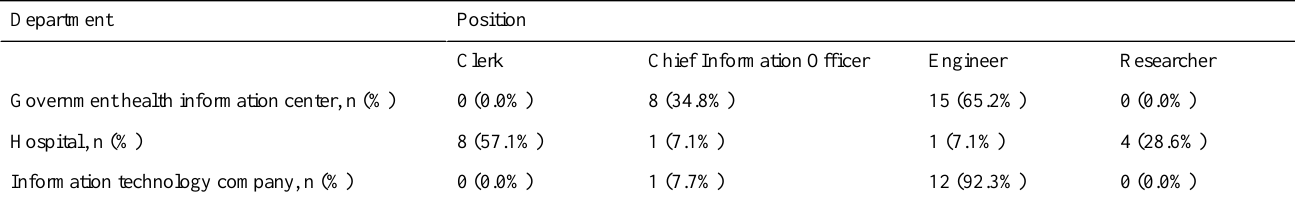
Table 2. Participant characteristics of the Part B questionnaire. PositionDepartment